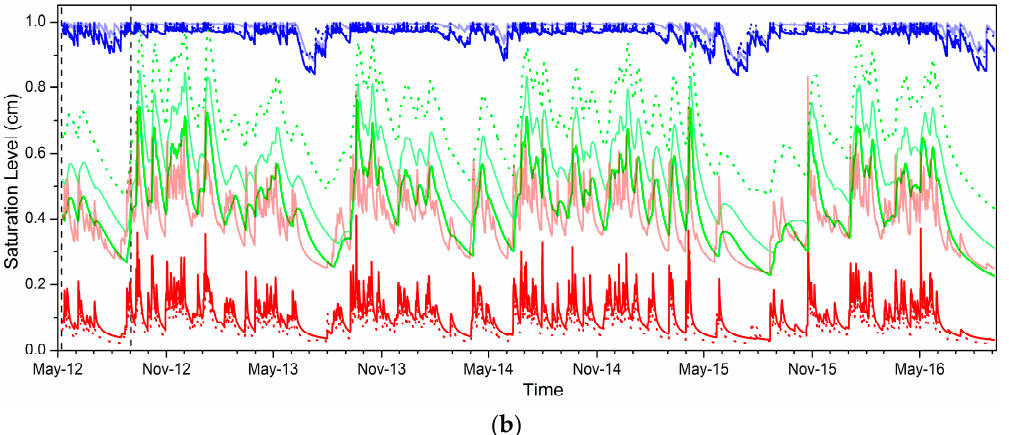
Figure 7. Saturation level modeled for the period from May 2012 to September 2016 for a three-layer model. The model is calibrated using hourly, daily and weekly data for the periods from April to December 2015 ( a ) and from June to September 2012 ( b ) (calibration period is limited by vertical straight lines on each picture).